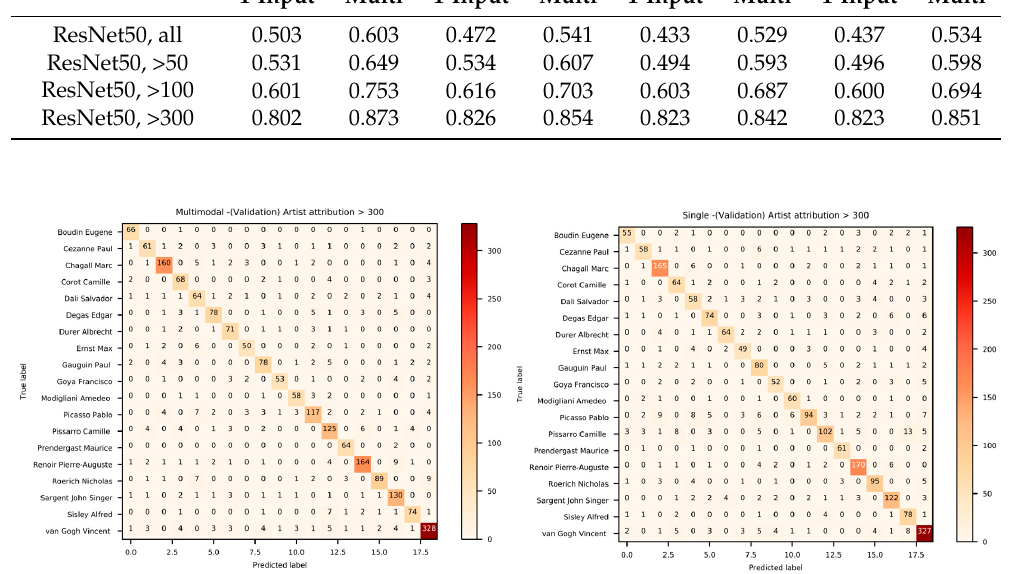
Table 5. Classification metrics of our approach (multimodal classification) against a single-input model (image only classification) on the validation datasets (average results after five-fold cross-validation).